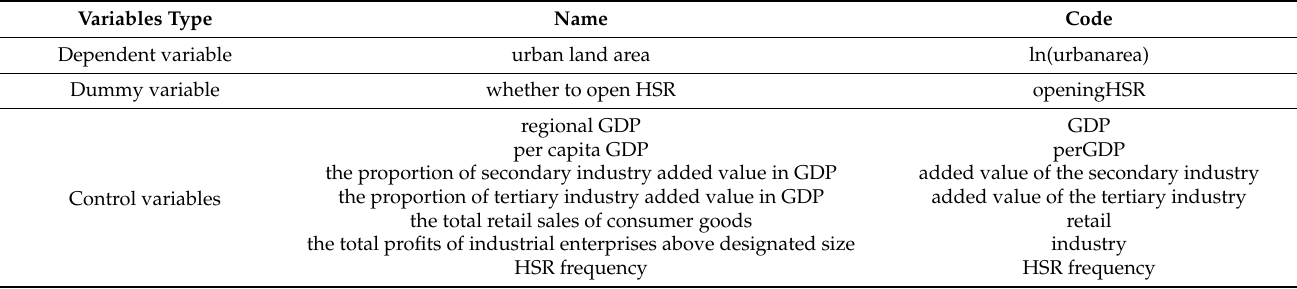
Table 1. The introduction and description of all